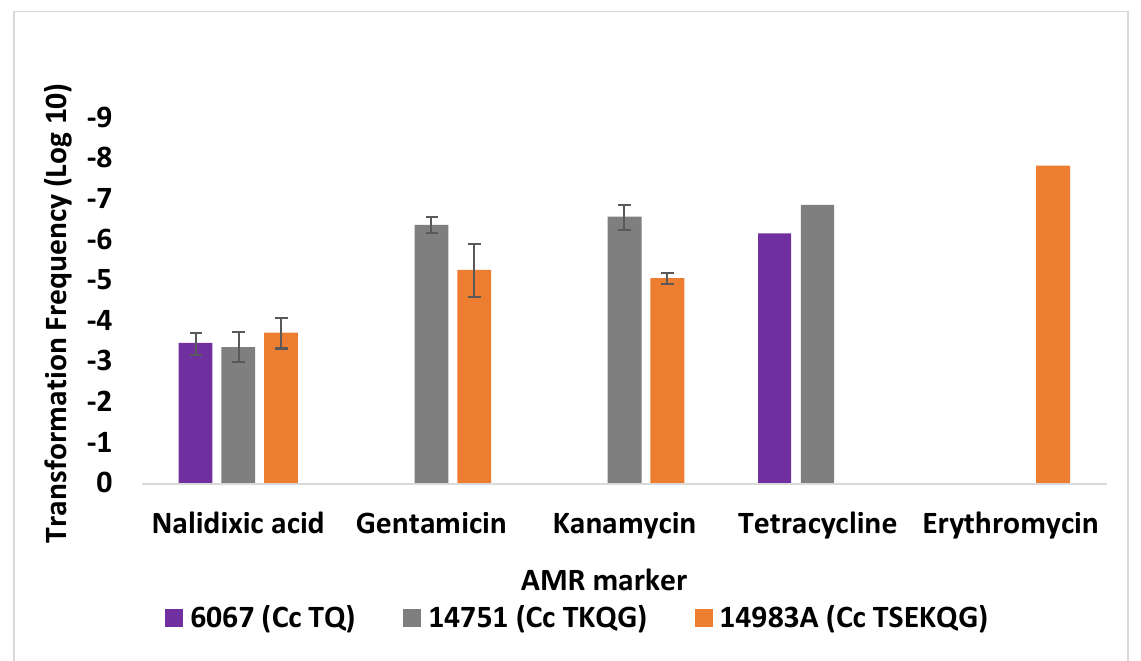
Figure 3. Transformation of C. jejuni SN:CM with DNA from a panel of C. coli donors. Transformation frequencies are averages from two or more independent trials for each recipient strain–donor DNA pair, and transformations were carried out as described in Materials and Methods. The data from transformations with C. coli 14983A shown in Figure 1 are included for comparisons. Cj and Cc in front of strain designations indicate C. jejuni and C. coli , respectively. AMR phenotype designations in strain names are as in the legend to Figure 2. The error bars on the columns with the transformation frequency data for tetracycline and erythromycin resistance were too small to be visible.